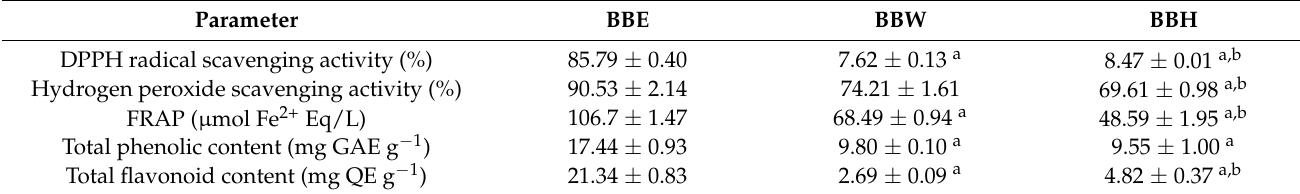
Table 2. In vitro antioxidant activities of BBE, BBW and BBH